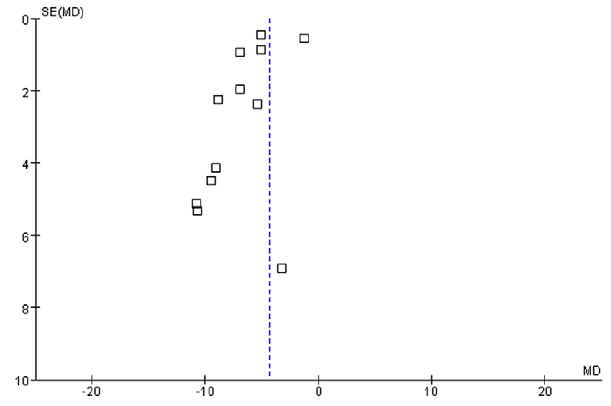
Figure 5. Herbal medicine plus active drug versus active drug, funnel plot for total UPDRS score.